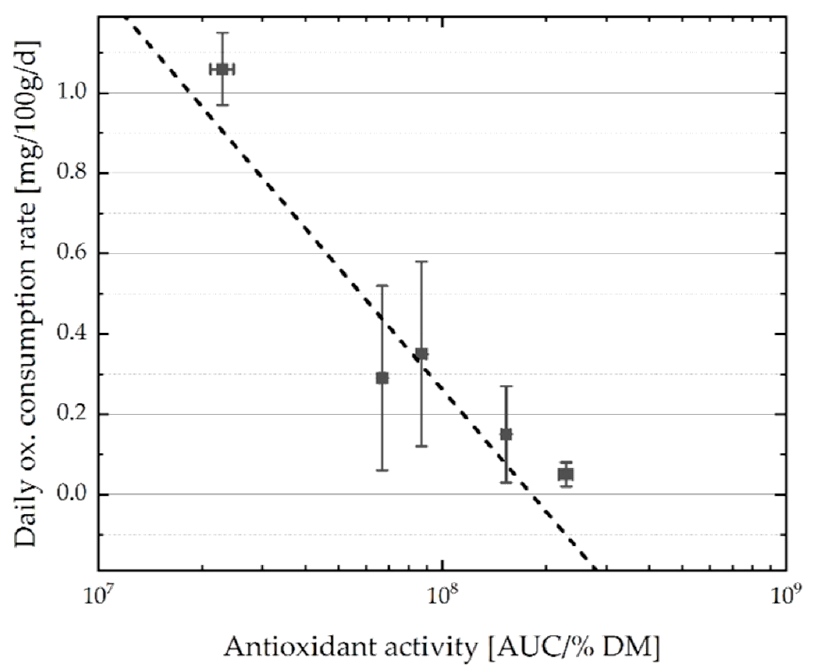
Figure 5. Daily oxygen consumption rate of O/W emulsions with plant extracts. The figure shows the daily oxygen consumption rate in mg O 2 per 100 g per day as a function of a storage time of 90 days at 30 °C for the O/W emulsions with and without extract in light and darkness, respectively, as mean values ( n = 3) with standard deviation (SD).